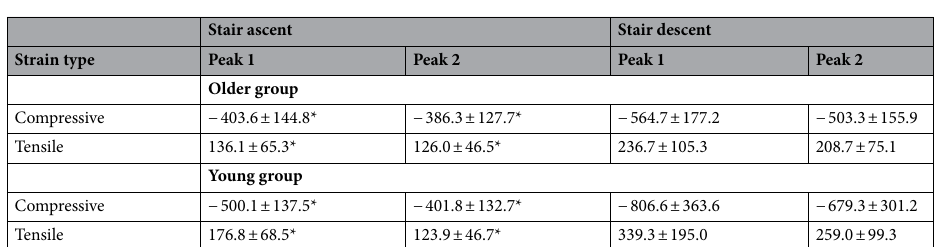
Table 1. Means ± SD of peak strains (µε) for the femoral neck for young and old groups during stair ascent and descent, strains were averaged among participants within the group. * stands for the significant difference comparing to stair descent ( P <